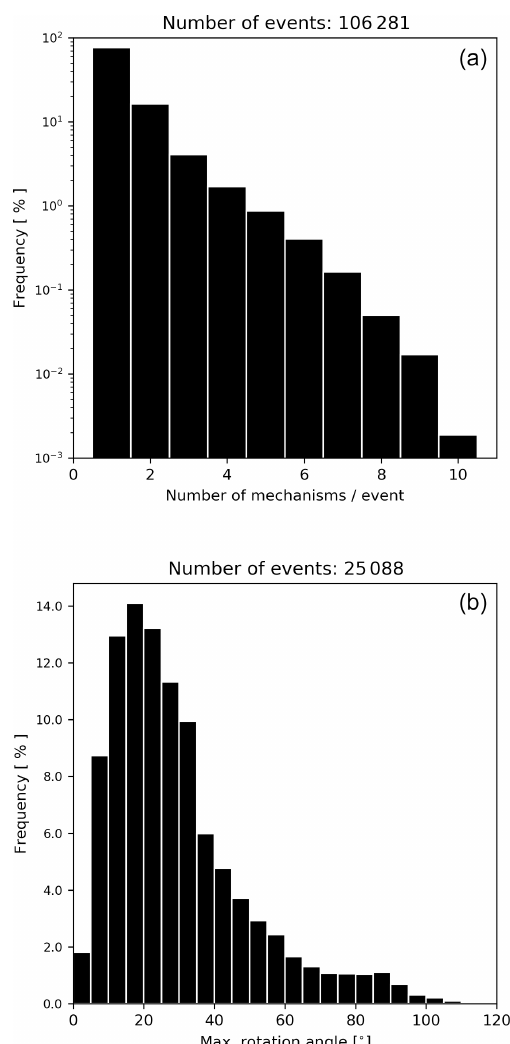
Figure 5. Frequency distribution of available source mechanisms per event in the ISC Bulletin for the time period from January 1964 to December 2018 (a) and intra-event maximum rotation angle fre- quency distribution for the seismic events with at least two mecha- nism solutions available (b)